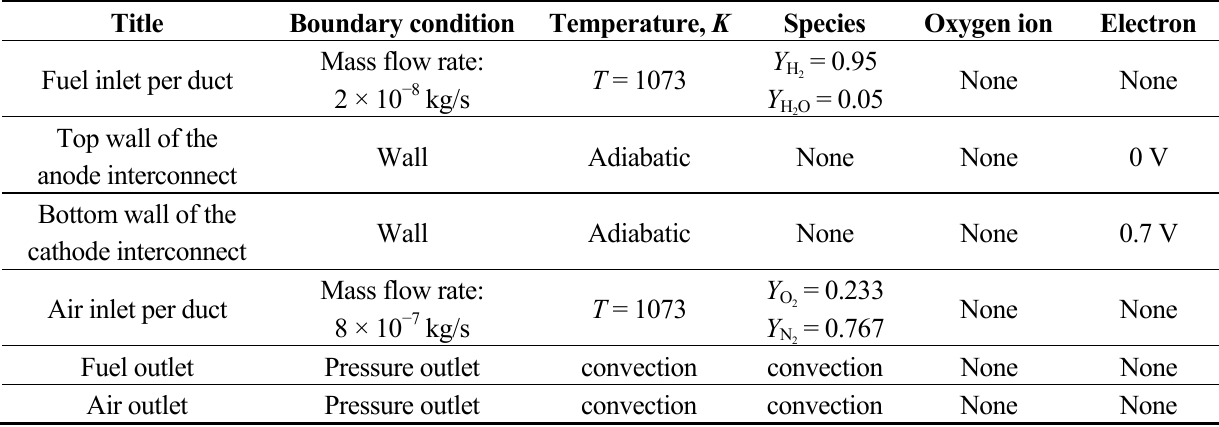
Table 5. Major boundary conditions of SOFC